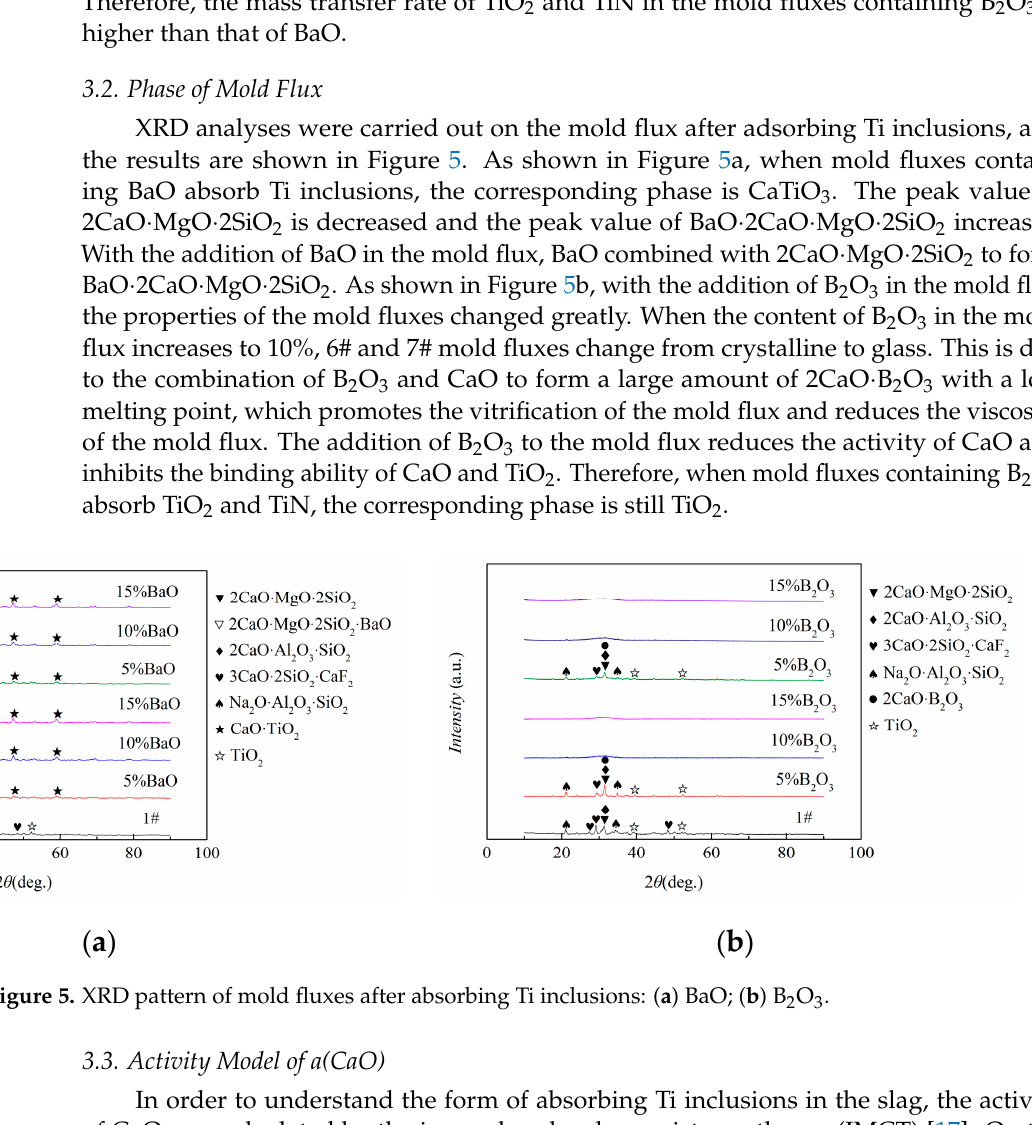
Table 2. Expression of structural units as ion couples or complex molecules, their mole numbers, and their mass action concentrations in 100 g of CaO-SiO 2 -Al 2 O 3 -Na 2 O-MgO-CaF 2 -BaO slags based on IMCT. Structural Units as Ion Item Couples or Molecules